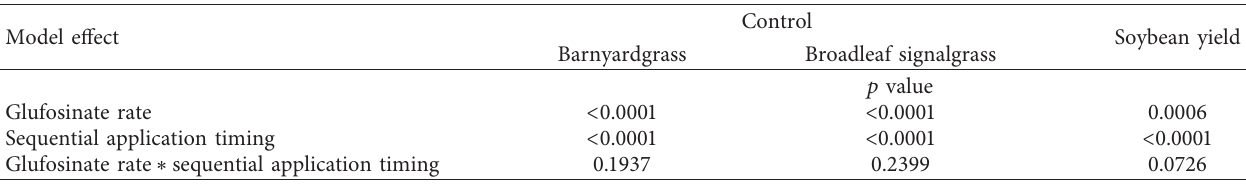
Table 6: Model effects and p values obtained from the ANOVA for barnyardgrass control, broadleaf signalgrass control, and soybean yield collected at harvest.